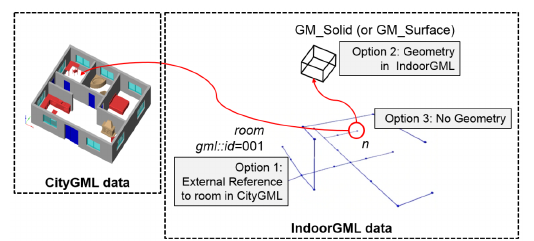
Figure 1. Three options to represent geometry in IndoorGML